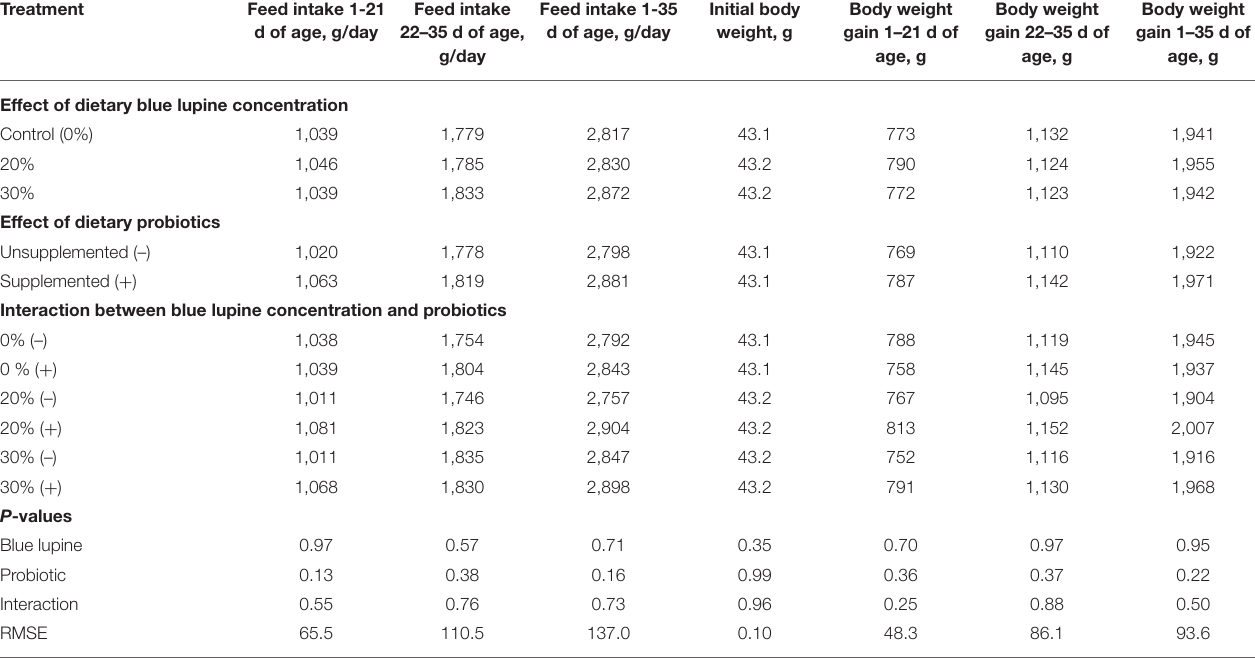
TABLE 3 | Effect of blue lupine and probiotics on the growth performance parameters of broiler chicks at 1–35 d of age.